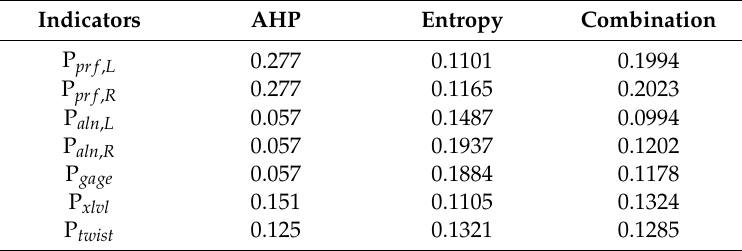
Table 6. Weight of each geometric parameter (unit: